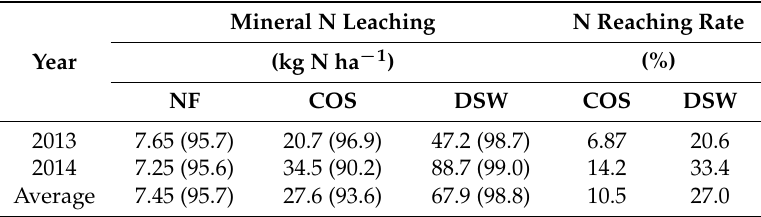
Table 4. Mineral nitrogen (N) leaching and N leaching rate in no fertilizer (NF), combined organic and synthetic fertilizer (COS), and distilled silage waste (DSW) treatments in a citrus orchard in southwestern Japan. Values in parentheses represent the contributions (%) of nitrate to mineral N leaching.